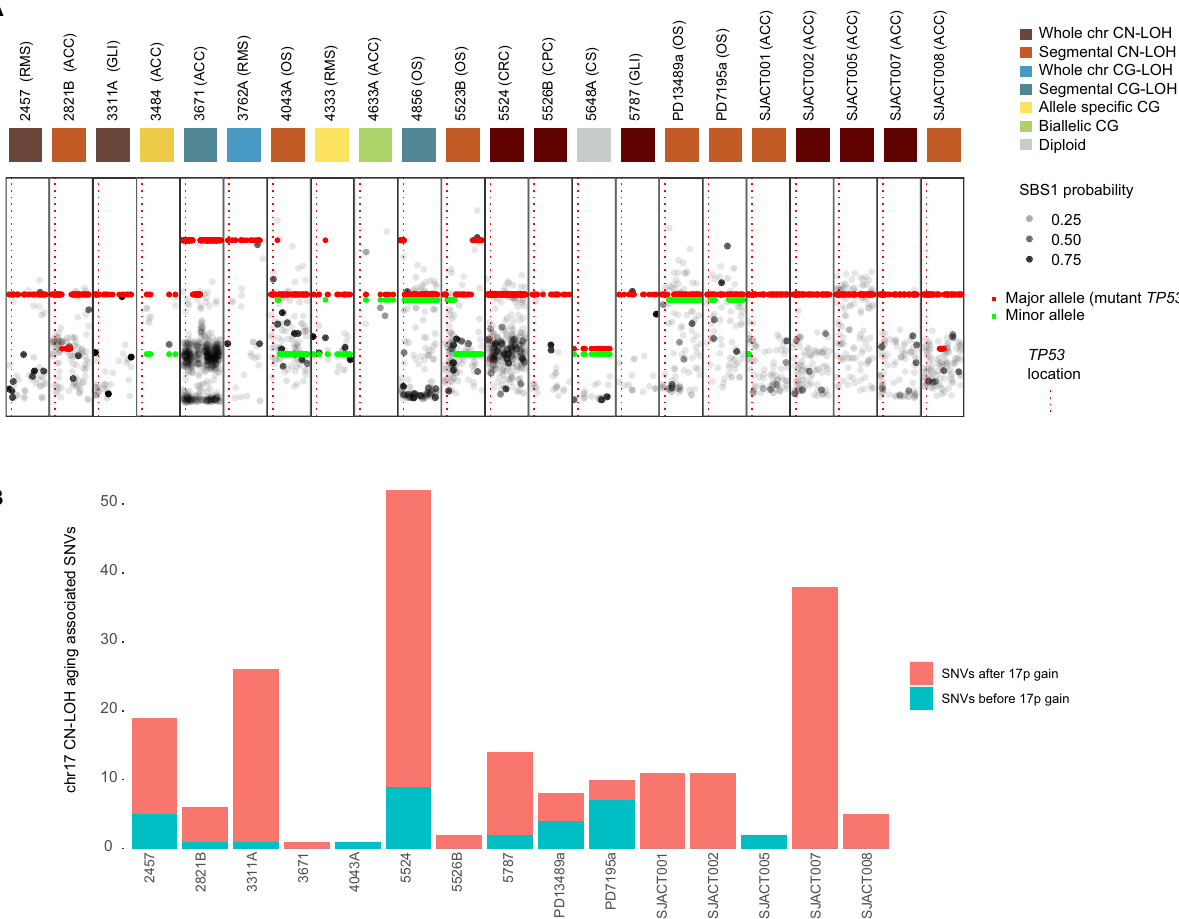
signature). Colored squares at top represent CN state of TP53 . CG copy gain. CN copy number. B Number of aging associated mutations (SBS1 or SBS5) occurring before (blue bar) and after (red bar) TP53 CN-LOH. X-axis depicts individual tumors. Y -axis depicts number of aging associated mutations. Source data are provided as a Source Data fi